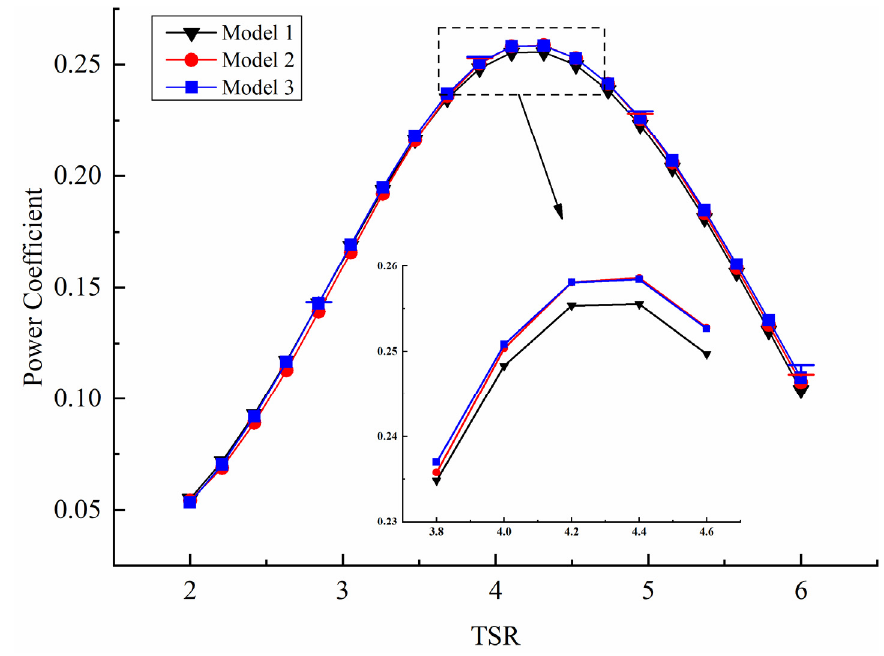
Figure 11. Comparison of power coefficients of different models. Table 6. Power coefficients of three models under different